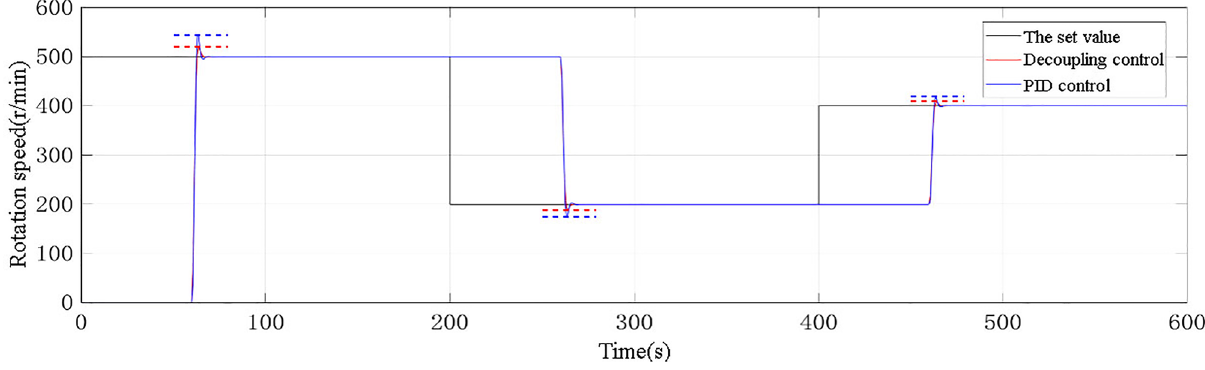
Figure 7. Curve of tracking performance.